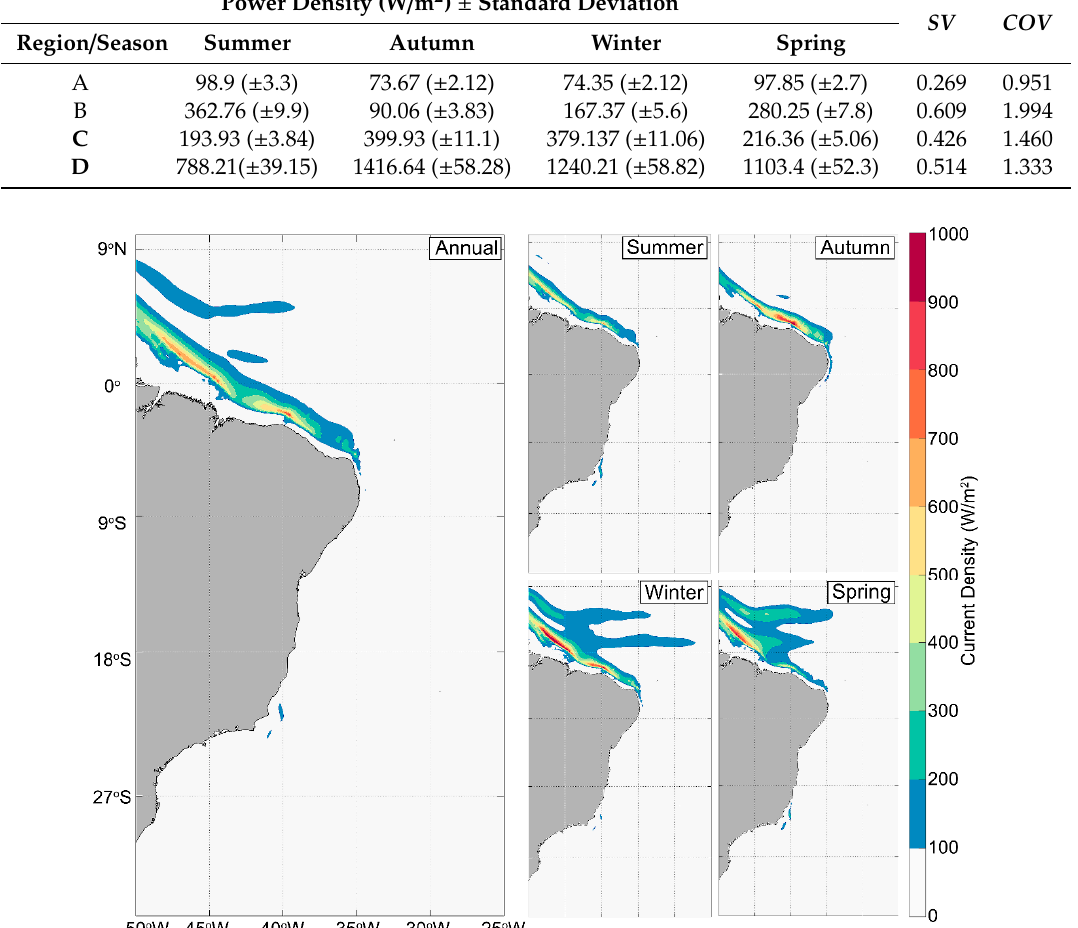
Table 3. Average values of the ocean current power density (W / m 2 ), standard deviation ( ± ), seasonal variability (SV), and coe ffi cient of variation (COV) for each coastline region—A, B, C and D—for each season (summer, autumn, winter, and spring) between January 1, 2007 and December